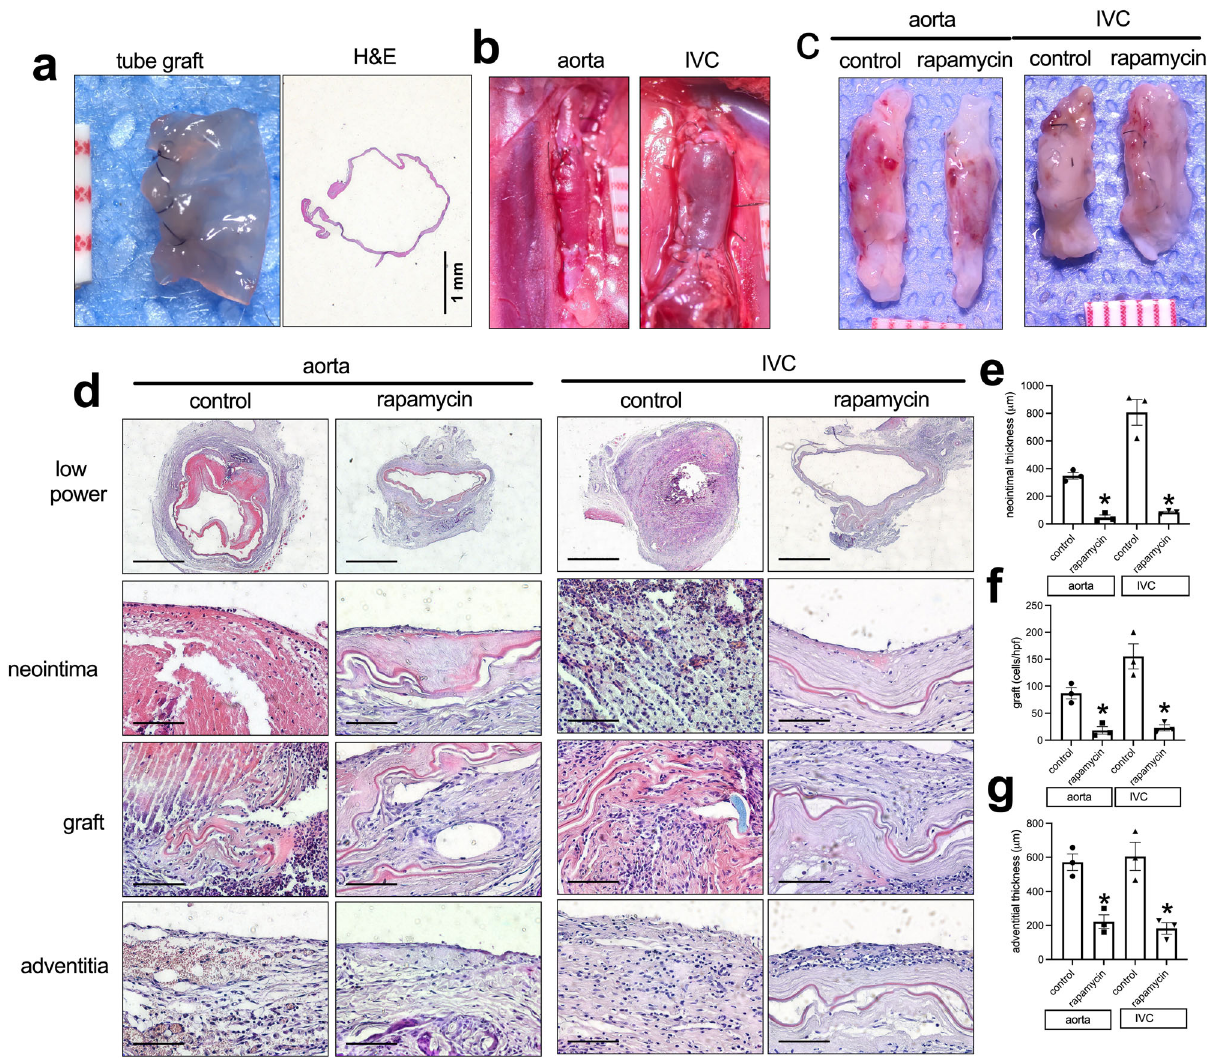
Fig. 6 Swim bladder used as a interposition tube graft in the aorta or IVC. a Photograph of a vascular tube made of decellularized swim bladder using 11- 0 suture; ruler marks 1 mm; H&E staining of a swim bladder tube before implantation. b Photographs of swim bladder interposition tube graft in aorta and IVC after completion of the anastomoses; ruler marks 1 mm. c Photographs of swim bladder interposition tube grafts, ruler marks 1 mm, day 14. d H&E staining of the swim bladder tube grafts, day 14. First row, low power photographs; scale bar, 1 mm. second row, high-power photographs shows the neointima; scale bar, 100 μ m; third row, high-power photographs shows the cells in fi ltrated into the swim bladder; scale bar, 100 μ m; fourth row, high- power shows the newly formed adventitia; scale bar, 100 μ m. e Bar graph showing the neointimal thickness in the aorta (* p = 0.005) and IVC (* p = 0.0015) interposition models, day 14; t -test; n = 3. f Bar graph showing the cells in fi ltrated into the interposition tube graft in the aorta (* p = 0.0054) and IVC (* p = 0.0092), day 14; t -test; n = 3. g Bar graph showing the adventitia; thickness in the aorta (* p = 0.0055) and IVC (* p = 0.0053) interposition models, day 14; t -test; n = 3. Data are expressed as mean ±